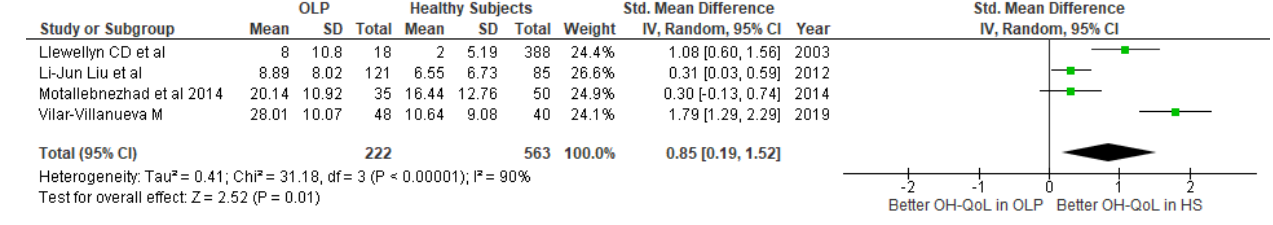
Figure 5. OHIP Score in OLP patients vs. Healthy subjects.